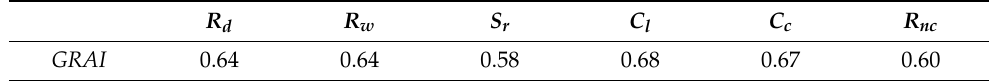
Table 3. The GRAI between RI and each SCC nationwide.